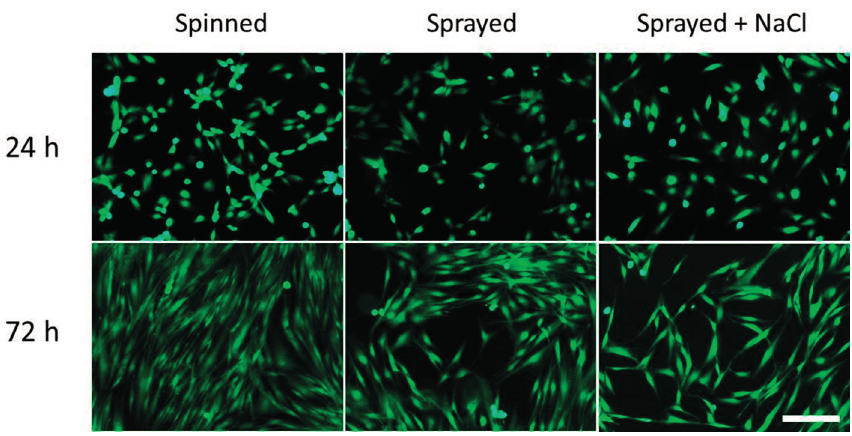
Figure 12. Fluorescence images (green = live cells) of nHDFs cultured on the different sample types, at the two time-points (24 h and 72 h). Scale bar = 100